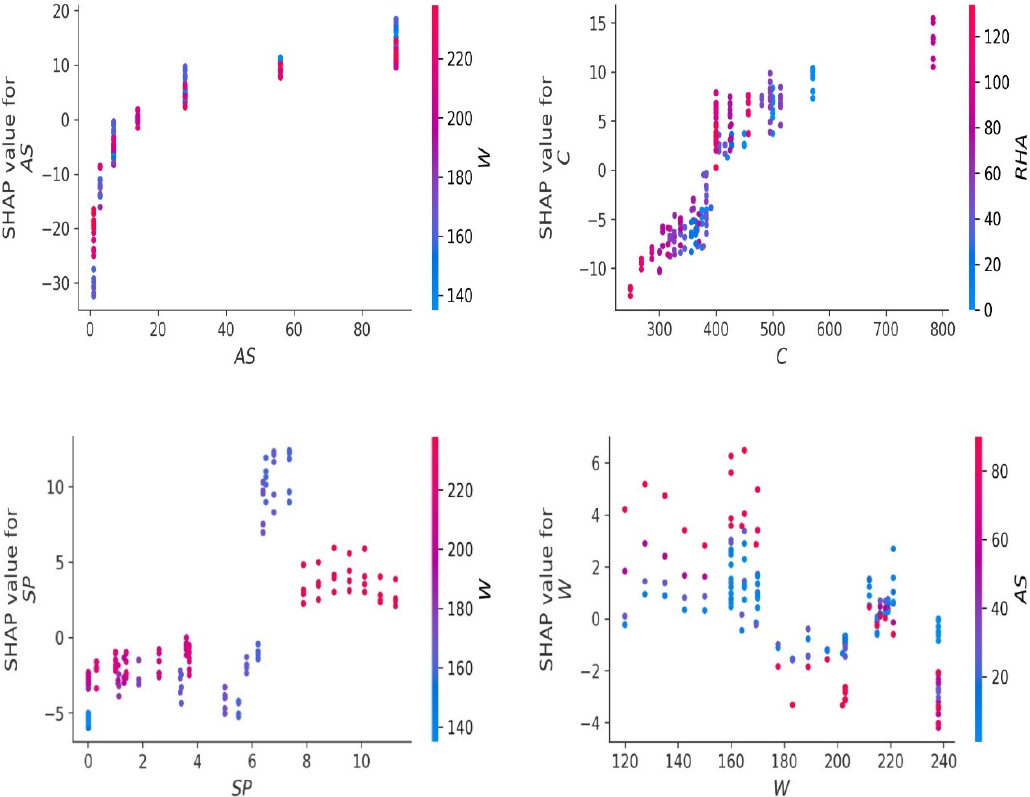
Figure 13. Feature reliance of the model.